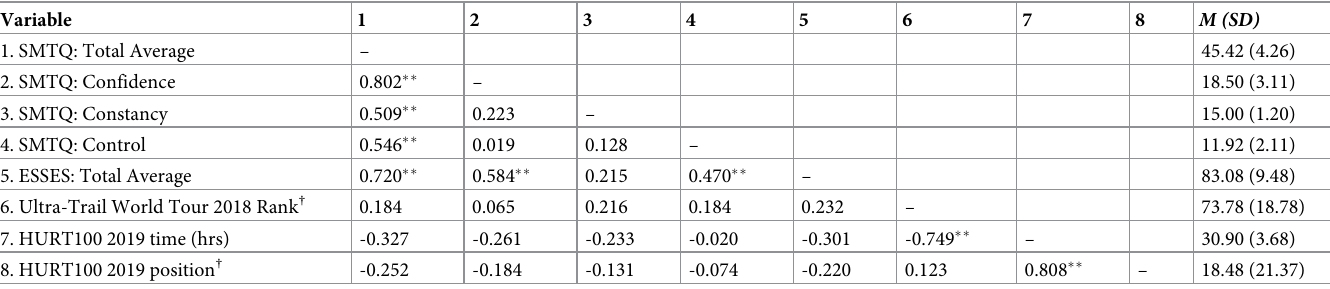
Table 2. Descriptive statistics and intercorrelations between measured variables (n = 56).